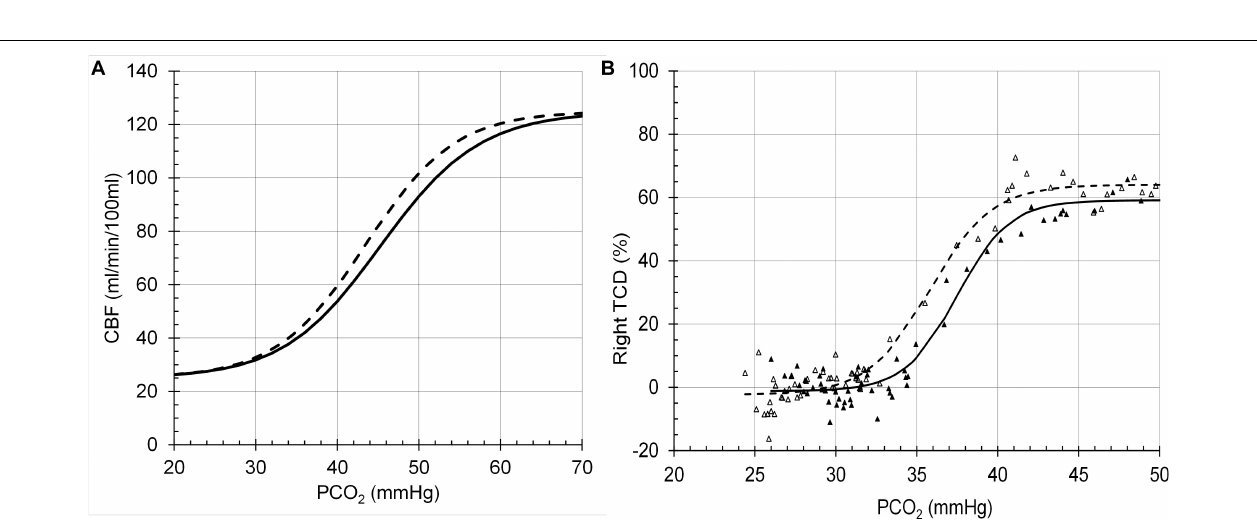
FIGURE 6 | Cerebral blood flow (CBF) responses to PCO 2 at PO 2 = 150 mmHg (solid line) and PO 2 = 50 (dashed line). (A) Model response. (B) Example transcranial Doppler (TCD) measurements of middle cerebral artery blood flow velocities (Battisti-Charbonney et al., 2011).